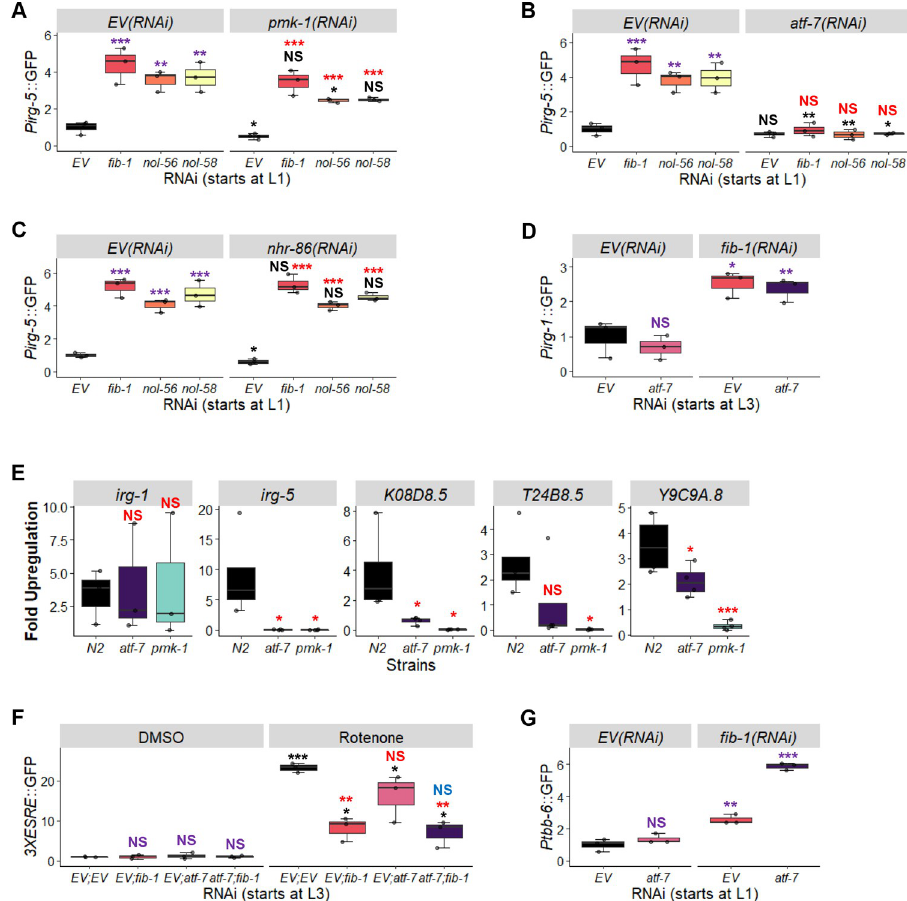
(RNAi); EV , EV; fib-1(RNAi) , or atf-7(RNAi); fib-1(RNAi) . In (F), worms were exposed to either DMSO (control) or 50 μ M rotenone for 8 hours prior to imaging. RNAi treatment was started at the L1 stage (A-C, G) or L3 stage (D-F). Three biological replicates with ~400 (GFP quantification) or ~8,000 (qRT-PCR) worms/replicate were used. p -values were determined from two-way ANOVA, followed by Dunnett’s test, or Student’s t -test for GFP quantification assay, or one-way ANOVA, followed by Dunnett’s test for qRT-PCR data. NS not significant, � p < 0.05, �� p < 0.01, ��� p < 0.001. In panels with multi-colored significance marks, purple indicates comparison between gene(RNAi) and EV (RNAi) in control ( EV(RNAi) (A-C) or DMSO (F)) conditions. Red indicates comparison between gene(RNAi) and EV (RNAi) in pmk-1(RNAi) (A), atf-7(RNAi) (B), nhr-86(RNAi) (C), or rotenone (F). Black indicates comparison between pmk-1(RNAi) (A), atf-7 (RNAi) (B), nhr-86(RNAi) (C), or rotenone (F) to untreated controls in the same panel. Blue indicates comparison between atf-7(RNAi);fib-1(RNAi) and EV;fib-1(RNAi) after rotenone treatment